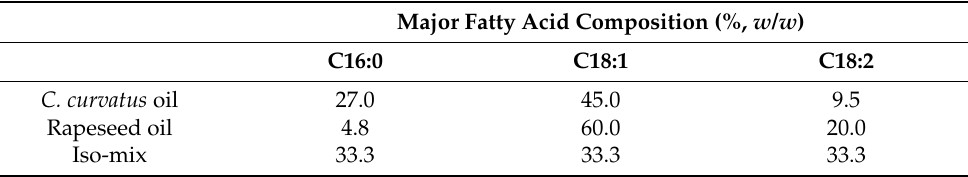
Table 7. The major fatty acid composition of oils and mixture used for the N-acylation of